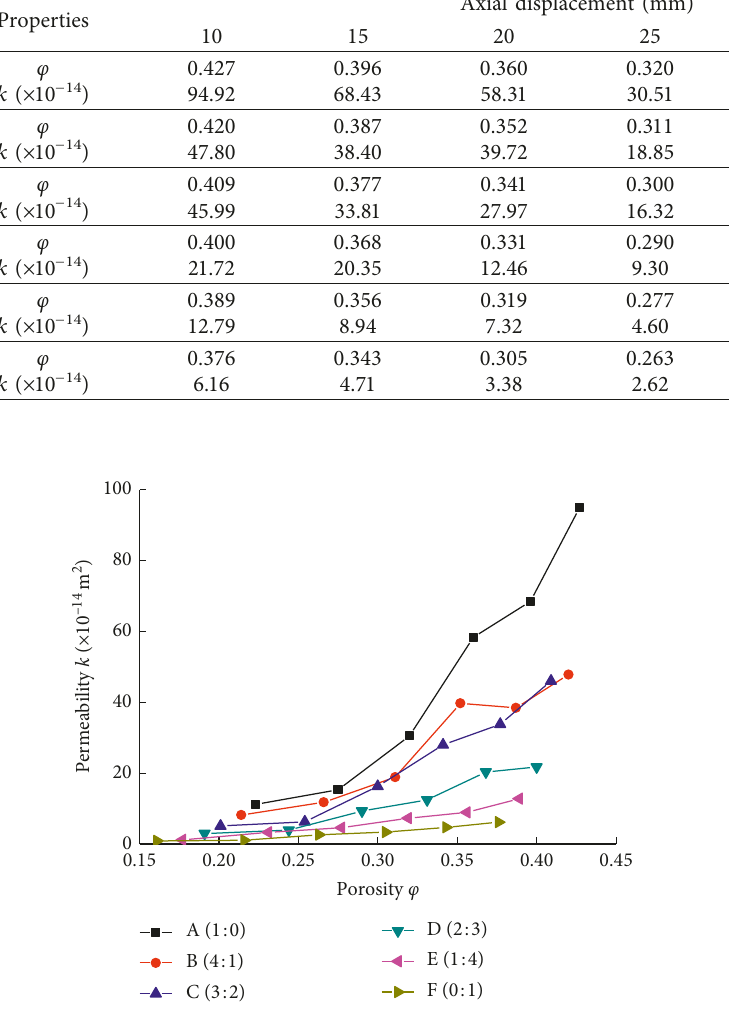
Figure 8: Permeability as a function of porosity of all the specimens